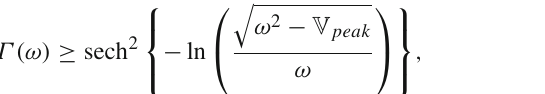
This result signifies that for very high frequency outgo- ing waves the potential barrier becomes almost